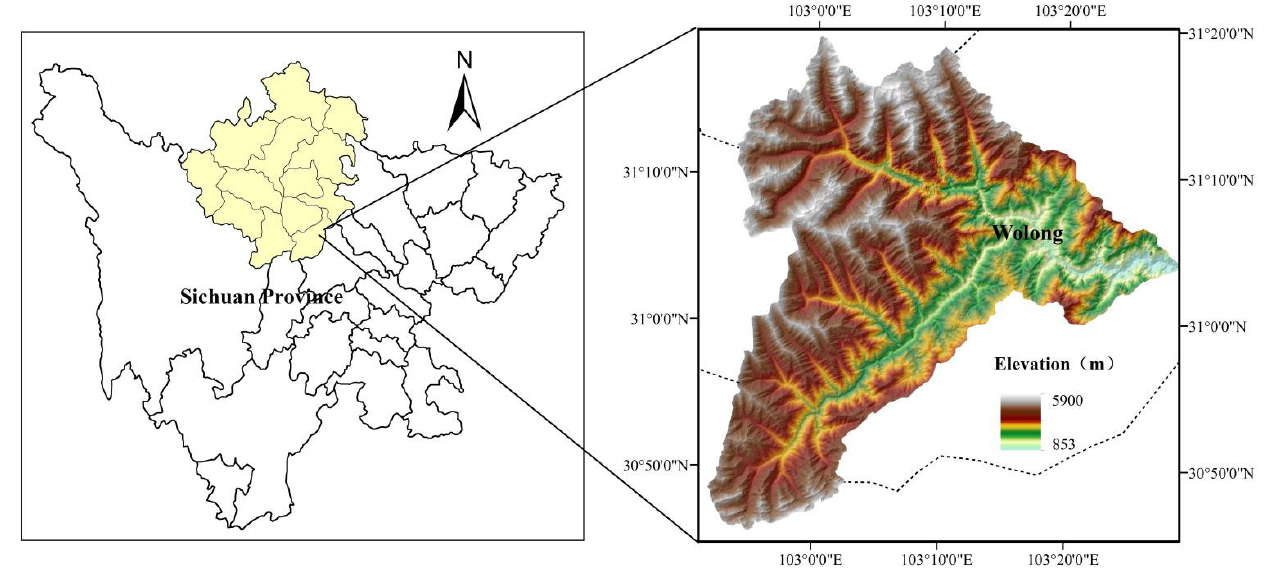
Figure 1. Location map of the study area and its Digital Elevation Model (DEM).